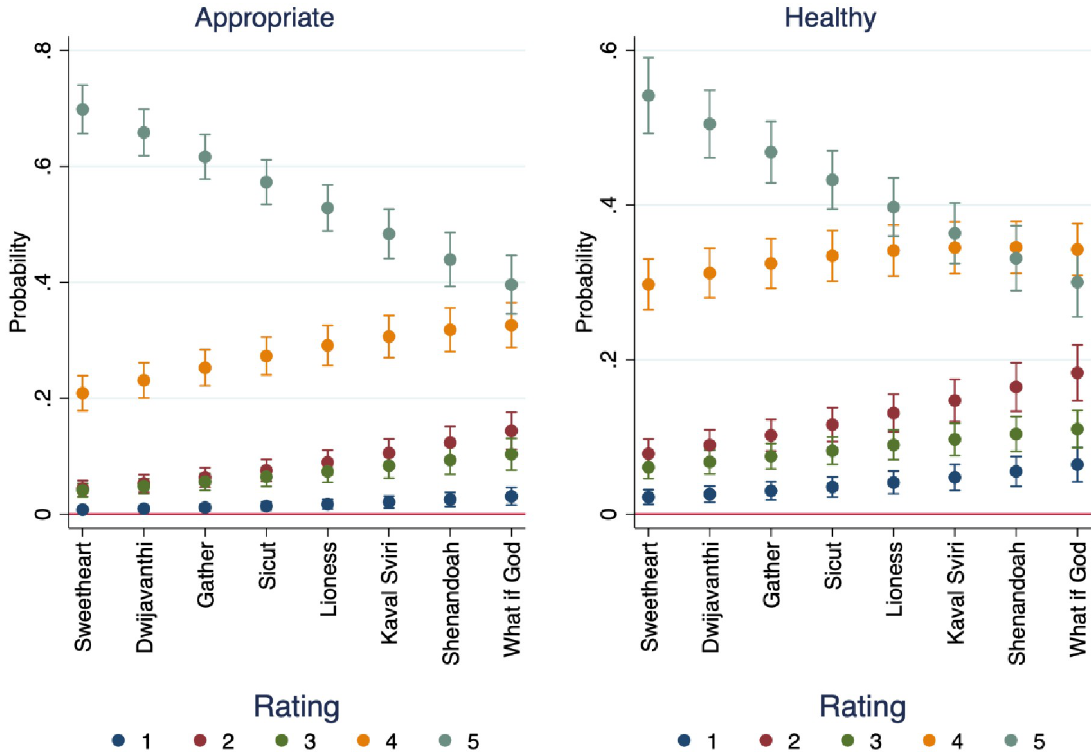
Fig 2. Probability of rating audio samples as healthy and appropriate, by audio